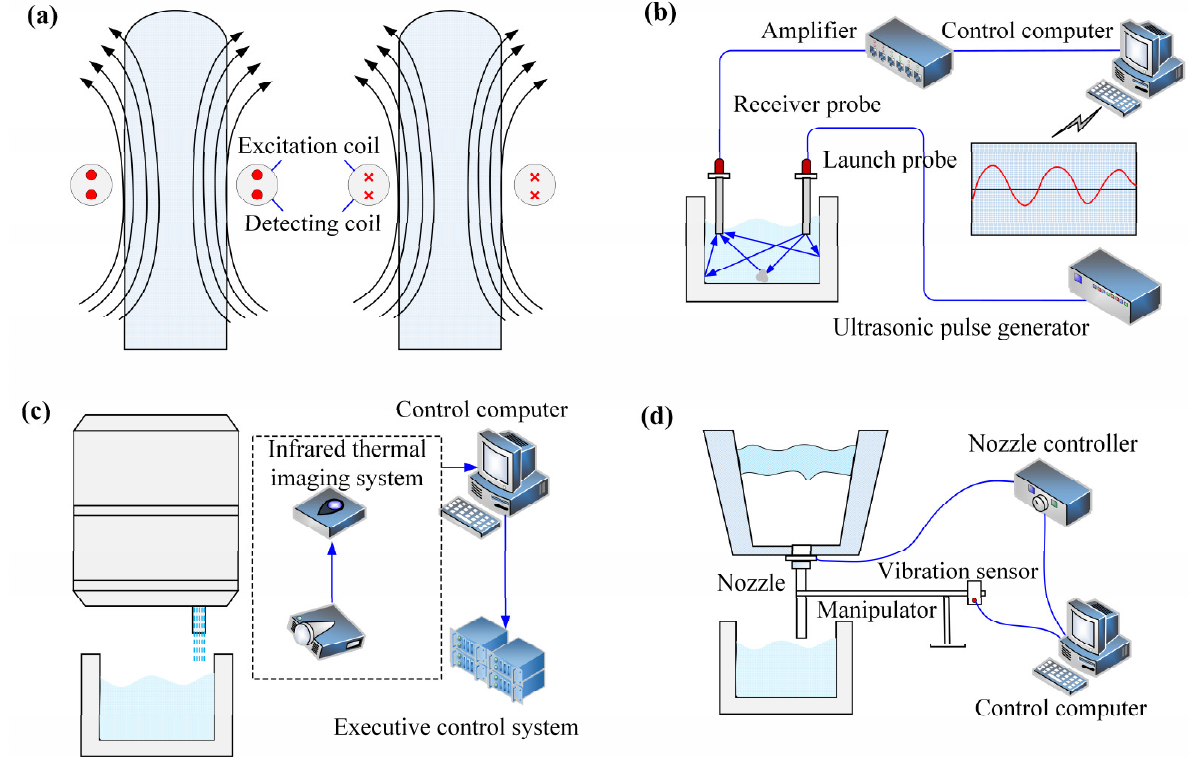
Figure 1. Vortex flow state detection technology. ( a ) Electromagnetic detection method. ( b ) Ultrasonic detection method. ( c ) Infrared detection method. ( d ) Vibration detection method.